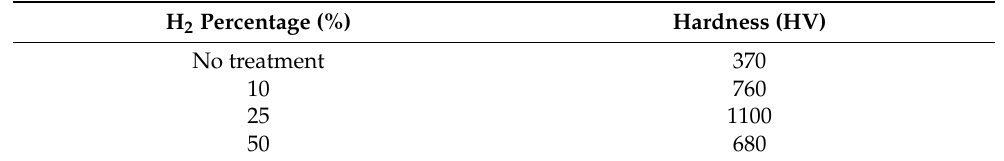
Table 2. The hydrogen gas content effect on the surface hardness of nitrided AISI304 disc specimen at 673 K for 14.4 ks.